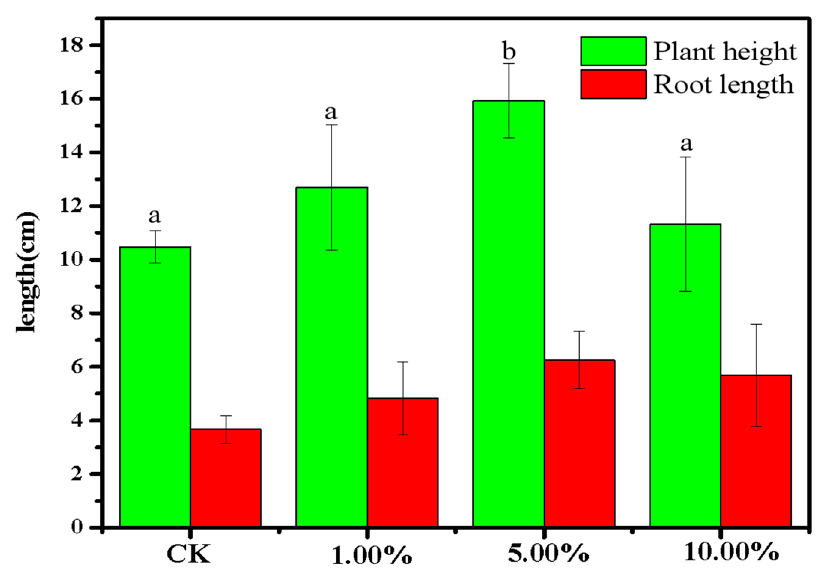
Figure 14. The growth of mung bean treated with phosphate-adsorbed LDHs-BC4. Different letters indicate statistically significant differences between the groups ( p < 0.05).